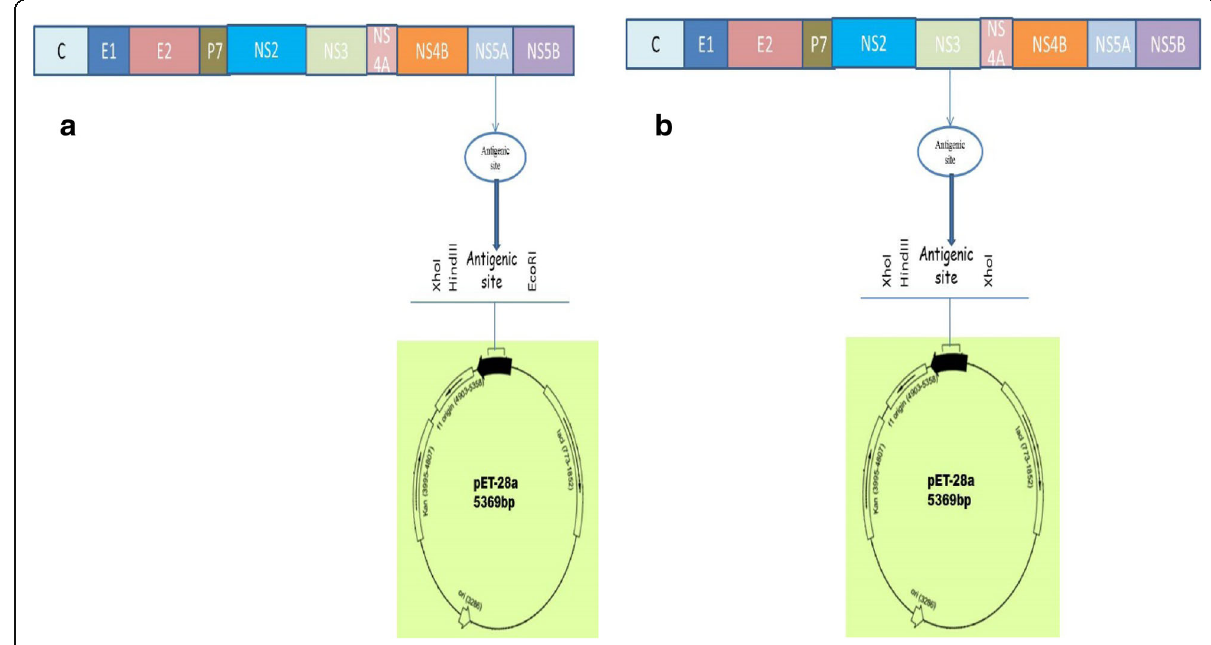
Fig. 4 pet28a constructs of NS3.1 ( a ) and NS5A.1 ( b ) encoding antigenic